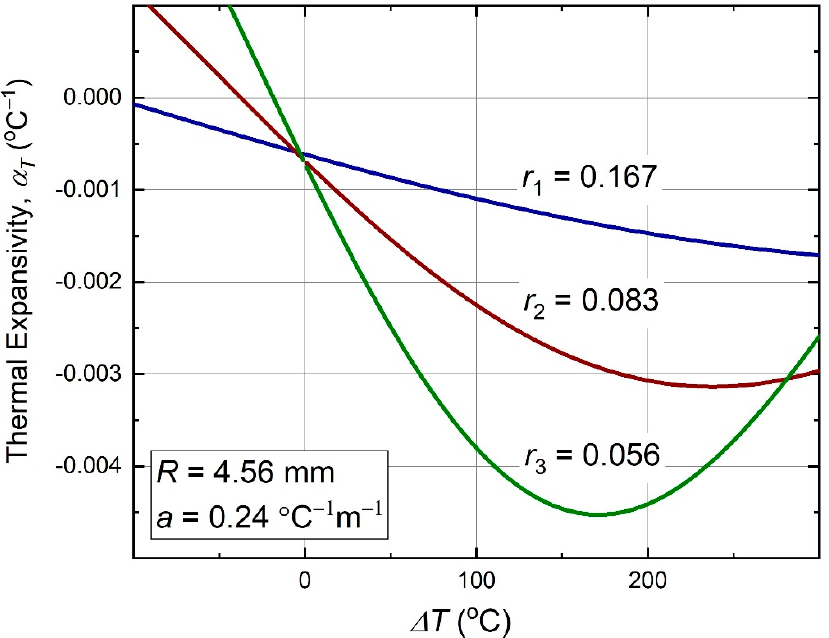
Figure 5. Thermal expansivity (10) of the antichiral metamaterial as function of temperature.